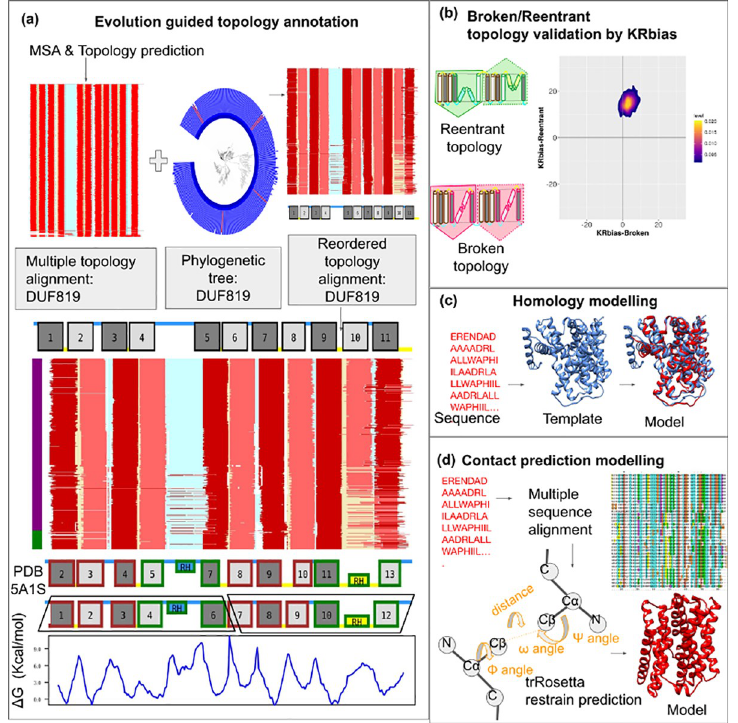
Fig 9. An example showing the annotation of the topology of DUF819 family using our integrated pipeline. The main steps involved in the pipeline are shown. (a) Evolution guided topology annotation: Topology predictions are mapped onto the seed MSA to obtain a multiple topology alignment. The phylogenetic tree from seed MSA is used to reorder the multiple topology alignment into a “Reordered topology alignment”. This evolution guided topology prediction is used to infer initial topologies for a family. Generation of the final topology and annotation of core and scaffold subdomains is obtained by comparing to the known structure of sodium-citrate symporter (PDB id: 5A1S). The TM helices (in-out) and TM helices (out-in) are colored dark red/grey and light red/grey, respectively. Reentrant helices (in-in) and (out-out) are colored yellow and blue respectively. The inside and outside loops are colored yellow and blue respectively. The vertical bar is colored based on the taxonomy of the sequences (Bacteria: Purple, Archaea: Dark blue Eukaryotes: Green). Scaffold subdomains and reentrant core subdomains are colored brown and green, respectively. N- and C-terminal repeats are shown as black trapezoids. Δ G values describing the hydrophobicity [65] are obtained for the representative sequence and are plotted to the aligned residues in the representative sequence. (b) Validation of broken/reentrant transporters by using the KRbias for the DUF819 family. KRbias or positive inside rule is the enrichment of inside loops compared to the outside loops of a transmembrane protein[36, 46, 47]. The number of Lys (K) and Arg(R) amino acids in the inside and outside loops are compared. The expected correct topology would show a higher KR-bias in one of the two topology models (Broken/Reentrant). The KR-bias plot is shown as a 2D scatter plot. (c) Homology modelling of the representative sequence (d) Contact prediction modelling